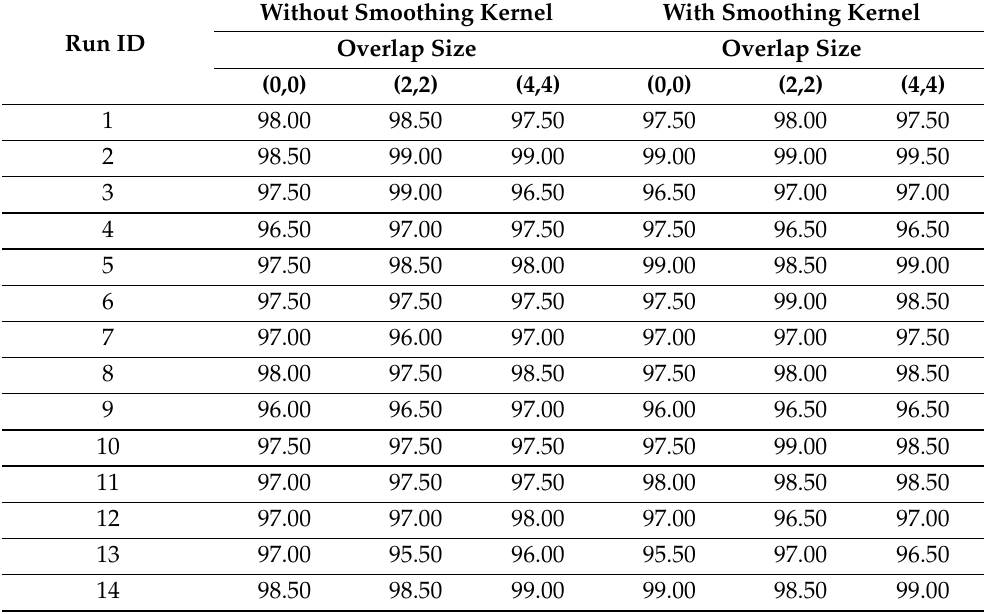
Table A9. The results of the runs for Salt and Pepper noise with density of 0.05.